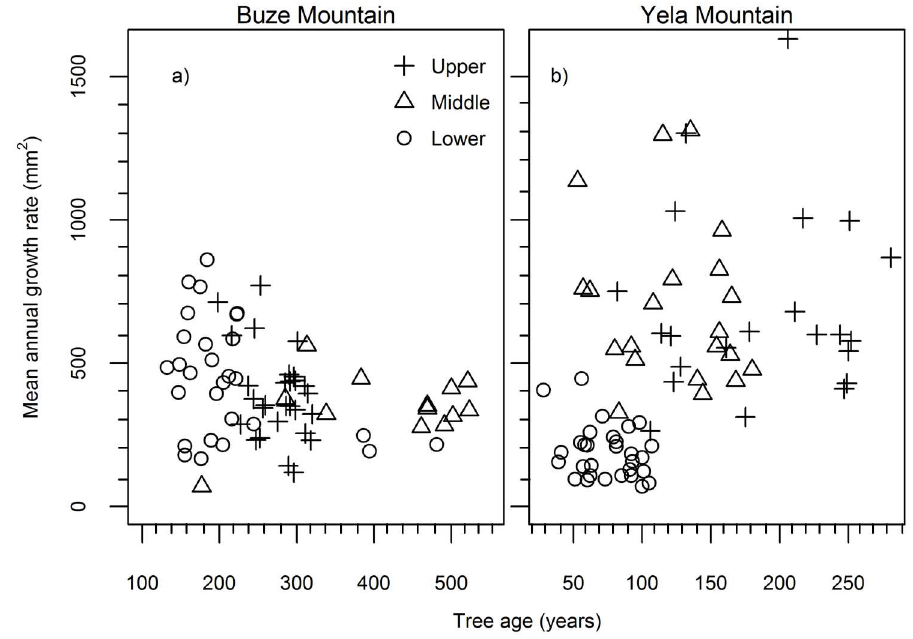
Fig 3. Mean annual growth rate (represented by basal area increment) of trees at three altitudes in Buze and Yela Mountains.